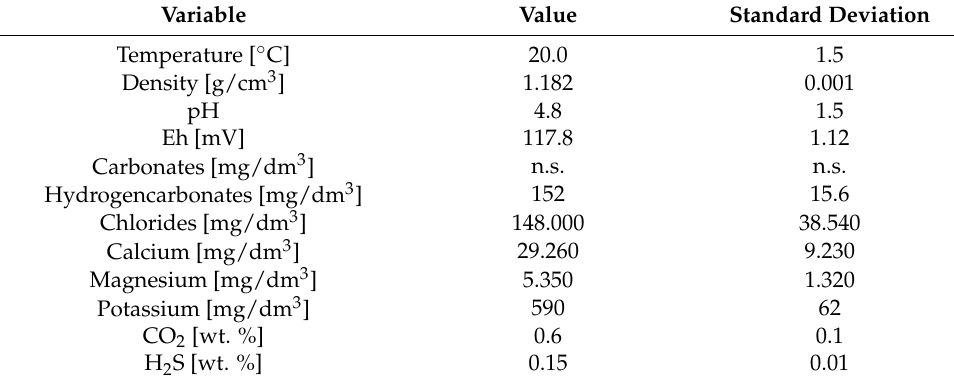
Table 1. Composition of deposit water.